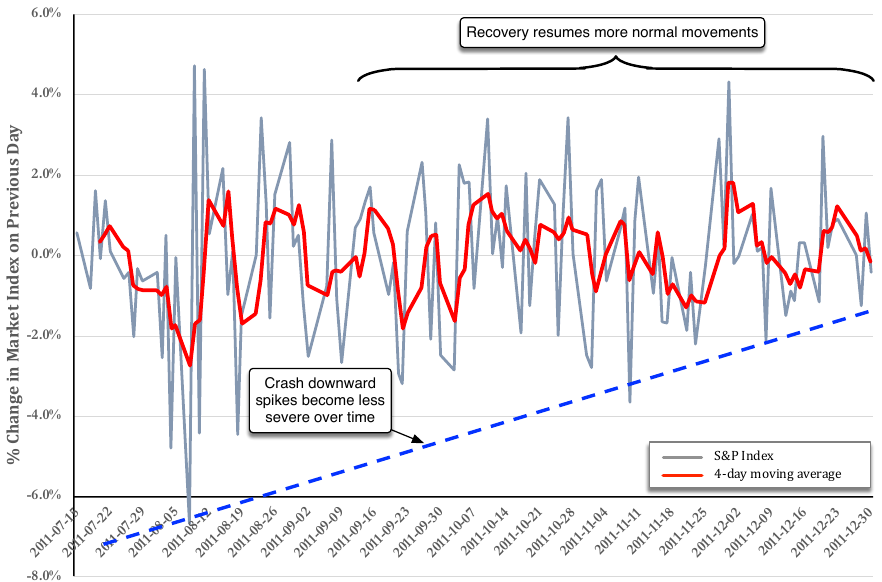
Figure 8. Daily % variation in S&P Index, 2011 Crash (NASDQ 2020).